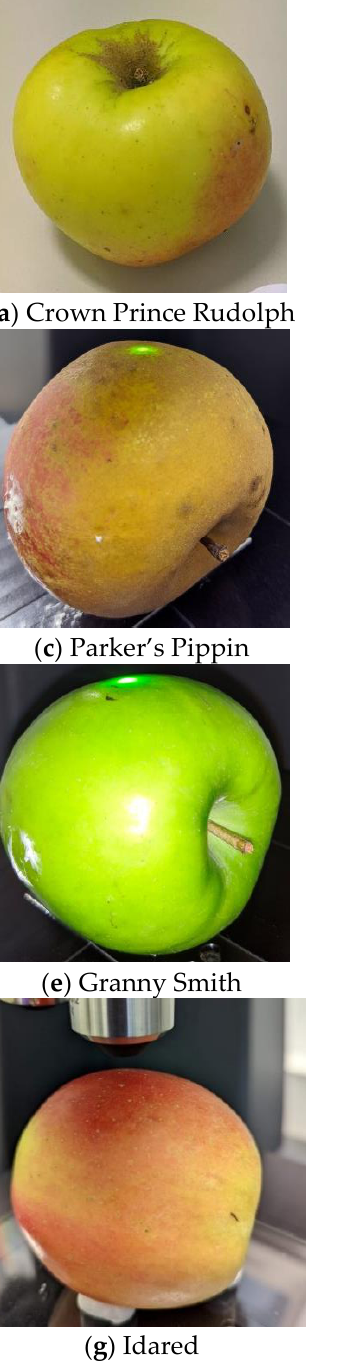
Figure 1. Autochthonous apple cultivars: ( a ) Crown Prince Rudolph, ( b ) Wax apple, ( c ) Parker’s Pippin, and ( d ) Green Renette; commercial cultivars: ( e ) Granny Smith, ( f ) Elstar, ( g ) Idared, and ( h ) Golden Delicious.